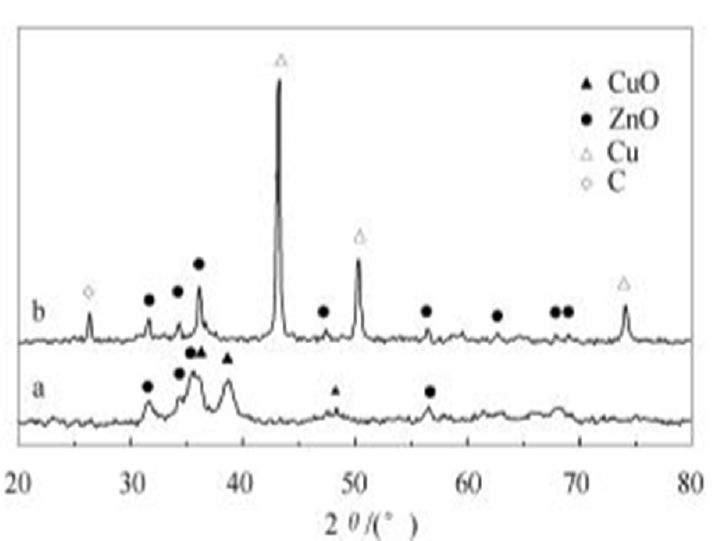
Figure 7. XRD result for a CZA catalyst before ( a ) and after the process ( b ). Reproduced with copyright permission from [82].